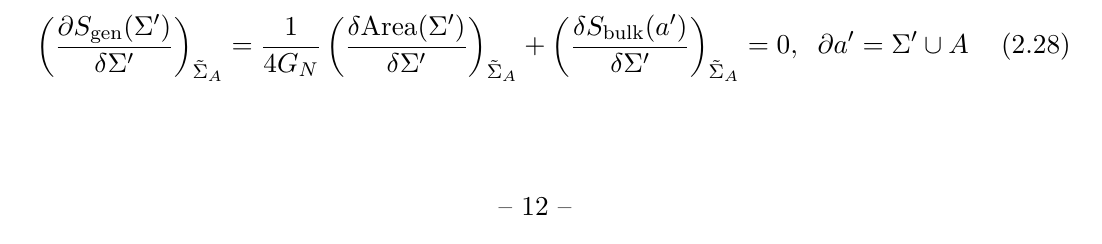
, with S + = S + in the form of N + ( ∂A ) ∪ S + A b b